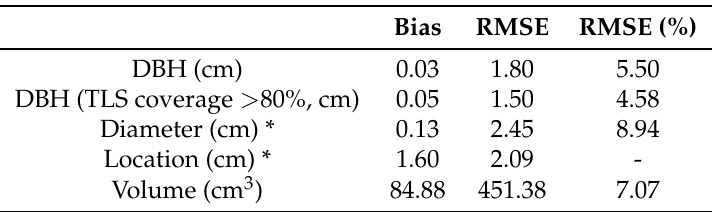
Table 3. Bias and RMSE of automatically estimated DBH, diameter, location and volume. * Results are evaluated from all heights along all stems.